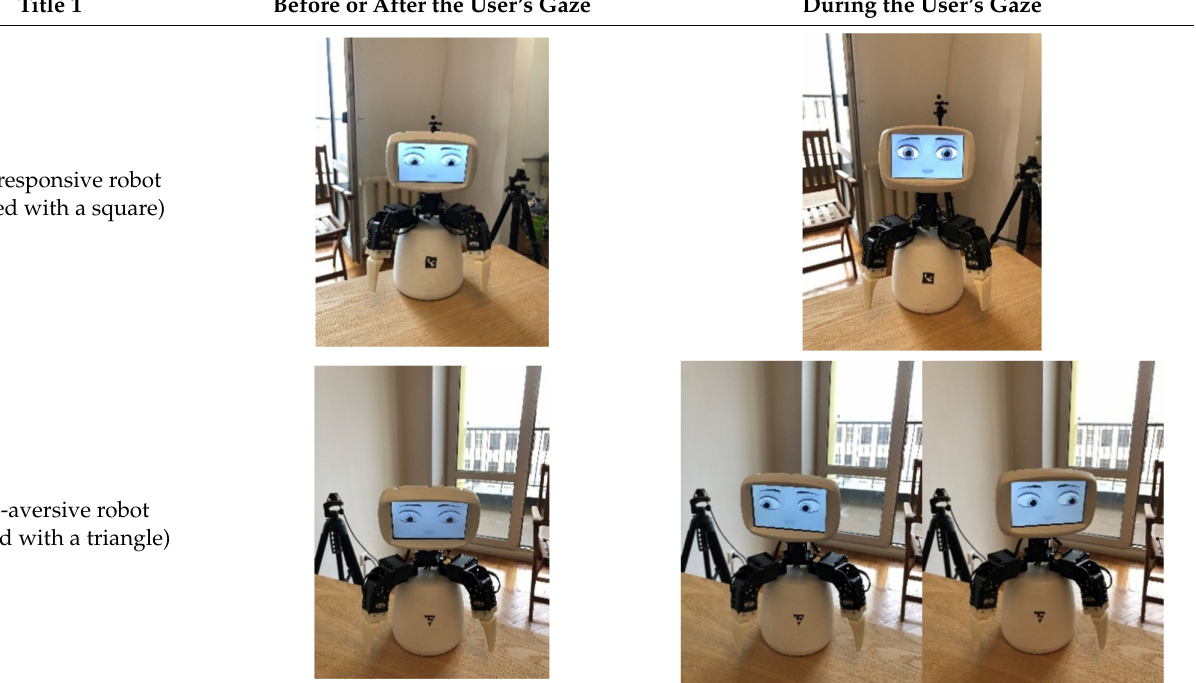
Table 1. Robots’ reactions to human gaze: gaze responsive and gaze aversive behavior. Title 1 Before or After the User’s Gaze During the User’s Gaze